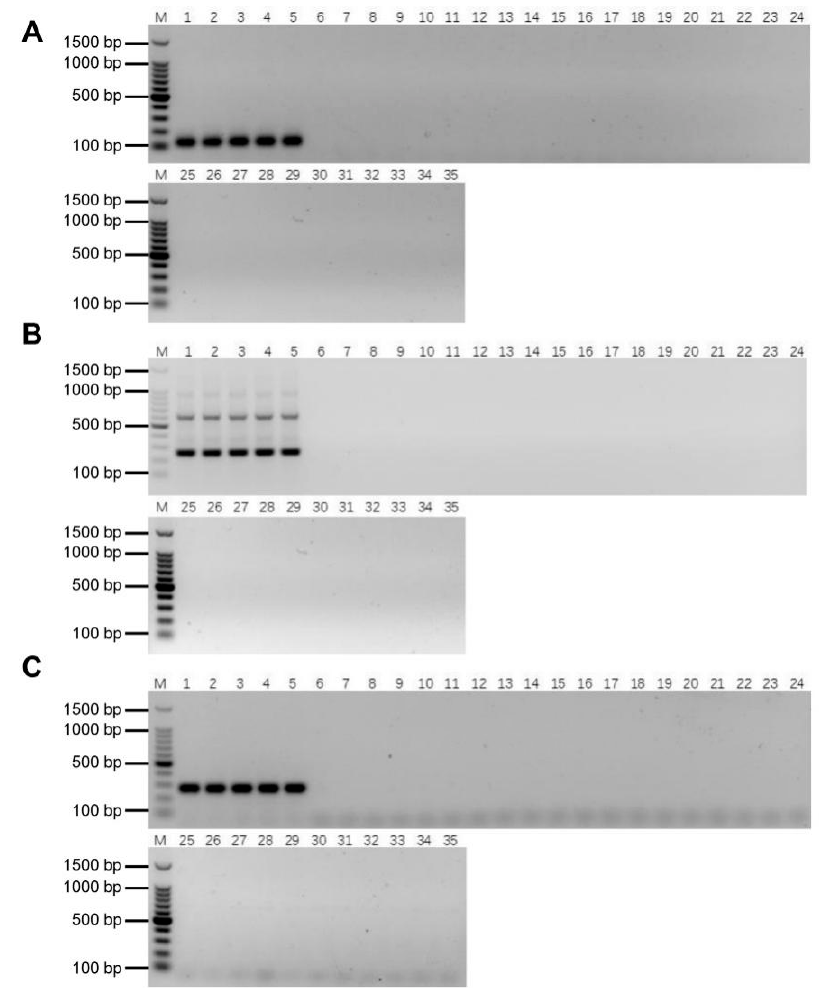
Figure 6. Validation of the specificity of E. arundinaceus -specific markers. ( A ) Ea086-128 primer; ( B ) Ea009-257 primer; ( C ) EaITS-278 primer. M: 100 bp DNA Ladder; 1–5: original species